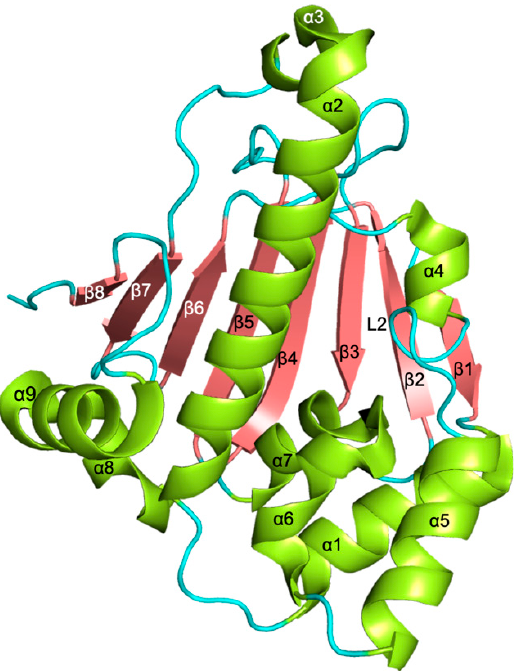
Figure 2. Cartoon representation of the tertiary structure of P. falciparum HSP90-NTD (ligand-free state; PDB code 3K60 [66]). The α -helices are colored light green, β sheets coral, and loops cyan.